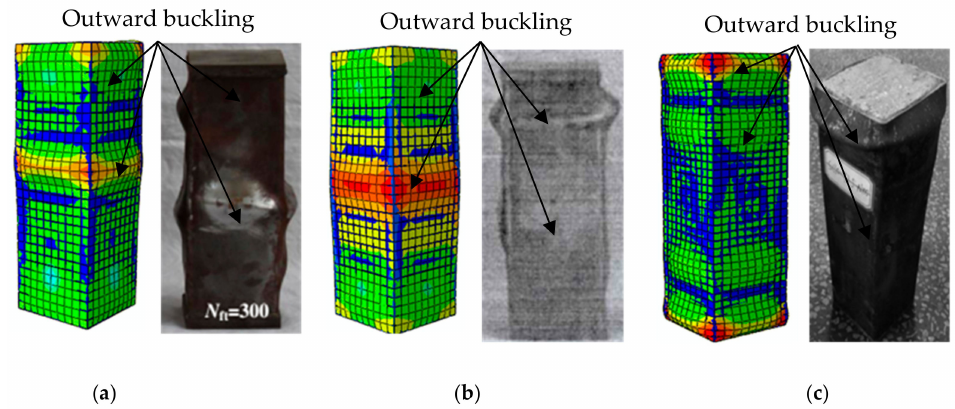
Figure 4. Comparison of failure modes between the numerical results and experimental results in the literature. ( a ) Sc1-300 specimen in [24]; ( b ) S2-100 specimen in [35]; and ( c ) SC30-T2.5-N100 specimen in [36].